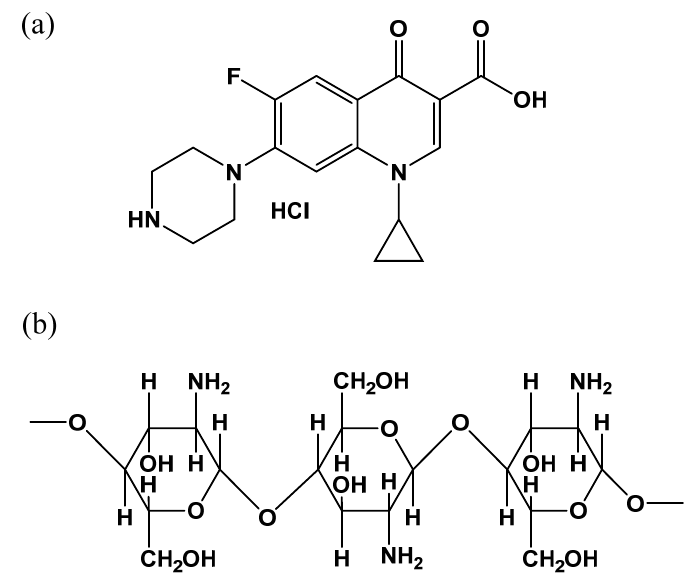
Figure 1. Structures of ( a ) CPF and ( b ) CS